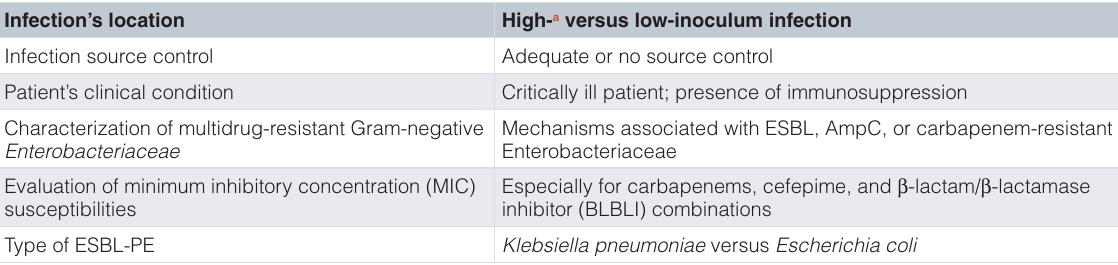
Table 1. Significant parameters for extended-spectrum β -lactamase-producing Enterobacteriaceae (ESBL-PE) antimicrobial